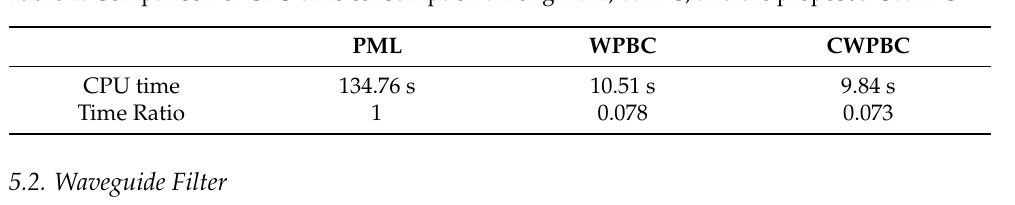
Table 1. Comparison of CPU time consumption among PML, WPBC, and the proposed